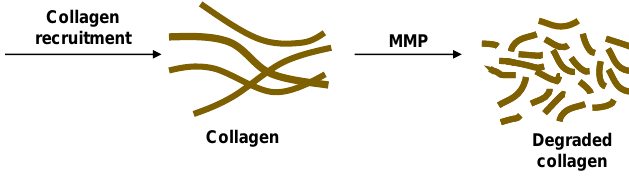
Figure 3. The initial formation of granulomas involves collagen recruitment to form the fibrillar collagen network of the stable granulomas in latent TB. Upregulation of MMP degrades the collagen making the granulomas penetrable by